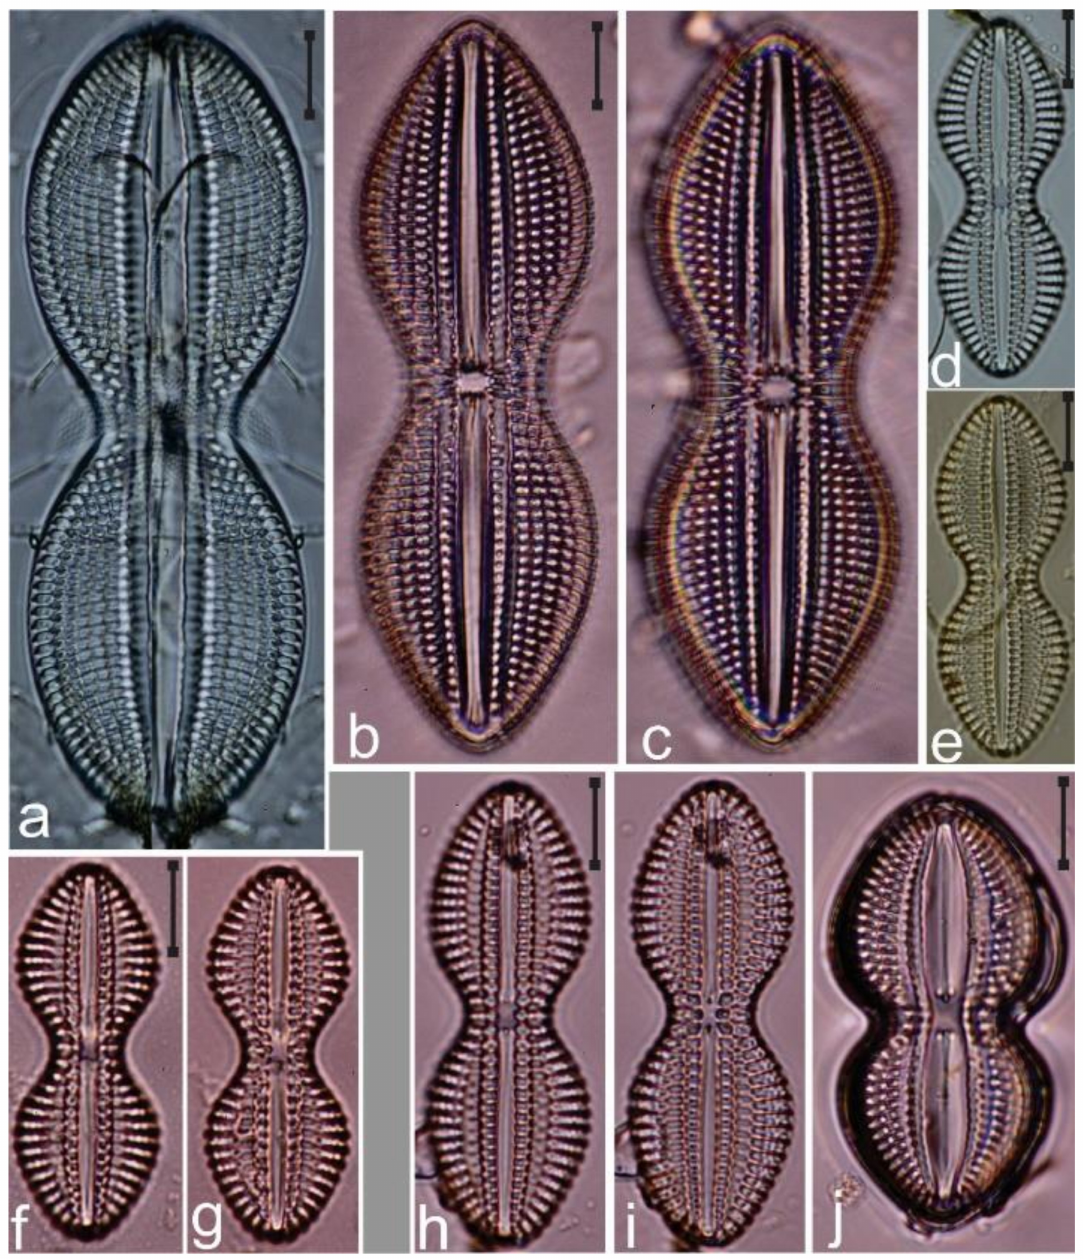
Figure 26. ( a ) Diploneis bombus ; ( b , c ) D. chersonensis ; ( d – i ) D. crabro valves at di ff erent focal planes and showing range in size; ( j ) D. gruendleri . Scale bar = 10 µ